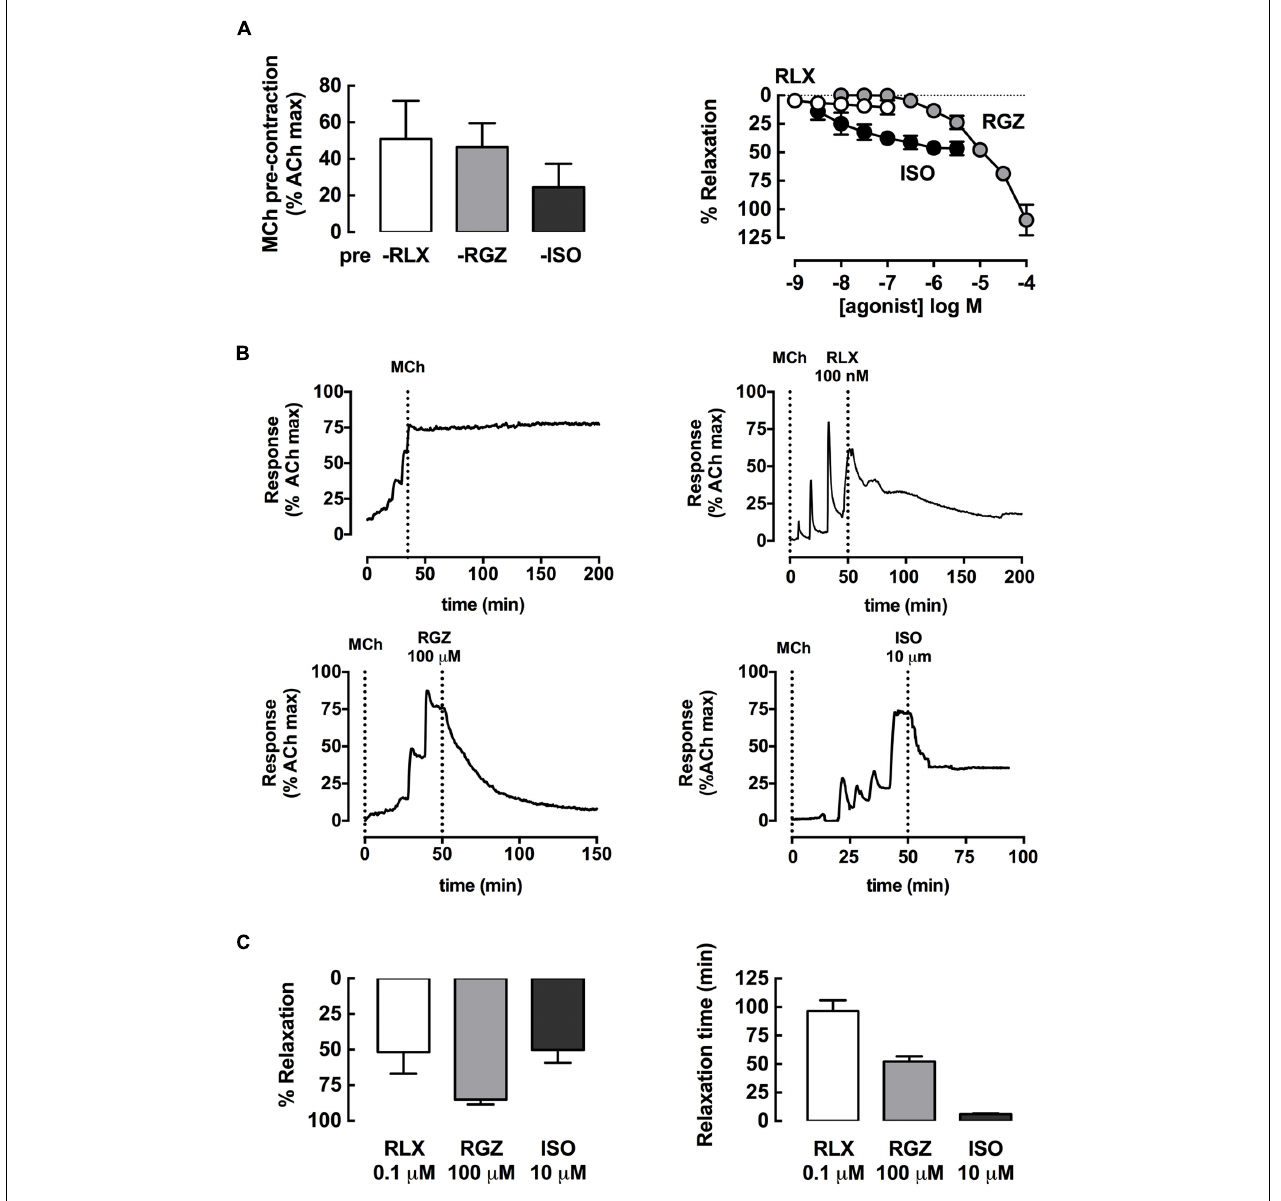
FIGURE 1 | rhRLX, RGZ, and ISO elicit relaxation of rat trachea. Rat trachea were mounted under isometric conditions for optimum development of contraction. Trachea were (A) precontracted with MCh, prior to preparation of concentration-response curves to rhRLX (RLX), RGZ, or ISO. (B) Representative traces show relaxation to RLX, RGZ, and ISO after MCh, as well as a time control for MCh alone. (C) Relaxation responses and time to maximum relaxation to single additions of RLX (0.1 µ M), RGZ (100 µ M), or ISO (1 µ M) were also assessed. Extent of relaxation is expressed as % of submaximal MCh pre-contraction, with relaxation time expressed in min (mean ± SEM for n = 4 per